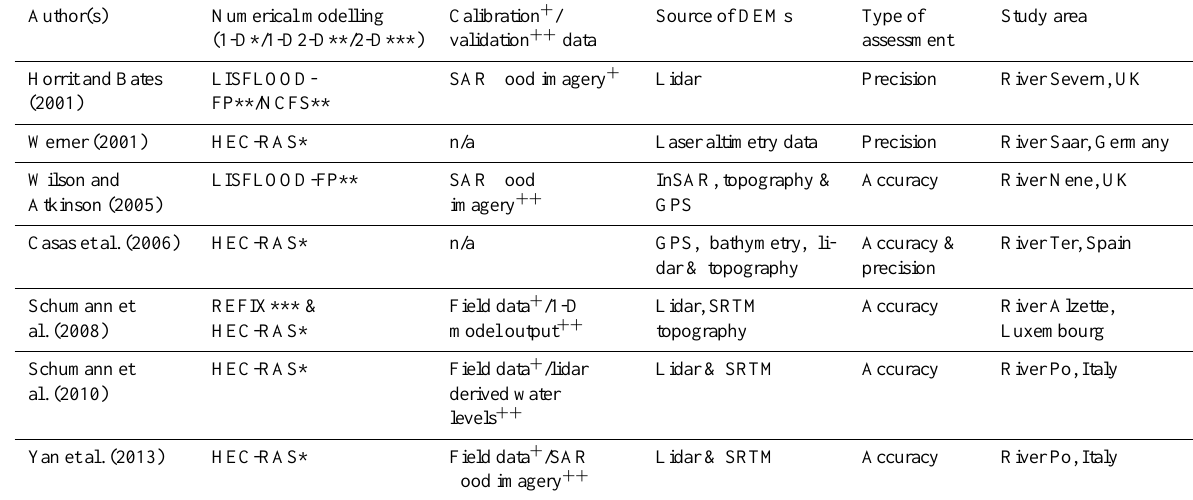
Table 1. Summary of studies assessing the impact of topographic input data on the results of flood inundation models.